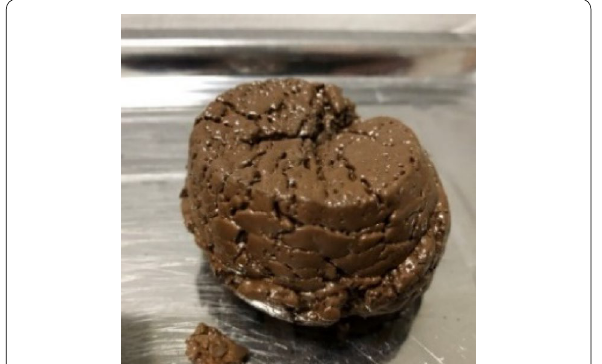
Fig. 4 Attapulgite calcined at 800 ℃ for 2 h (fully sintered).